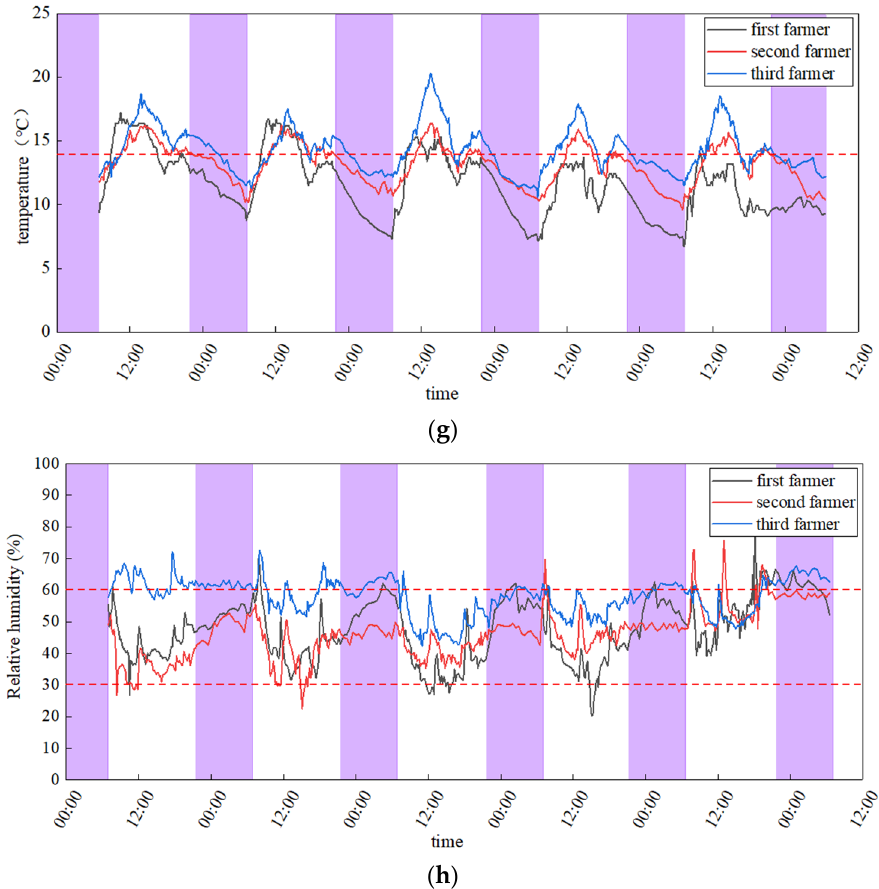
Figure 1. Field test of air quality in bedrooms of three farmhouses for 5 consecutive days: ( a ) CO 2 , ( b ) CO, ( c ) PM 2.5 , ( d ) PM 10 , ( e ) Formaldehyde, ( f ) TVOC, ( g ) temperature, ( h ) relative humidity.